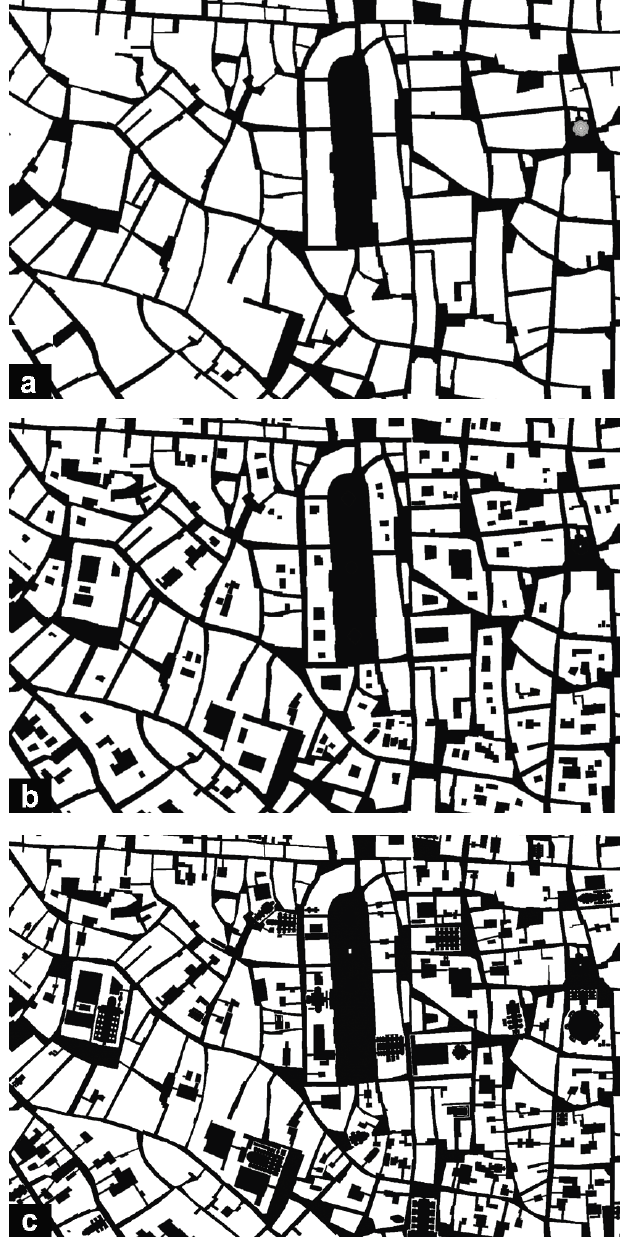
Figure 6. Vectorization of the Nuova pianta . Level of representation of the urban structure: ( a ) building blocks; ( b ) solids and voids; ( c ) including the plans of churches, noble palaces, arcades and covered